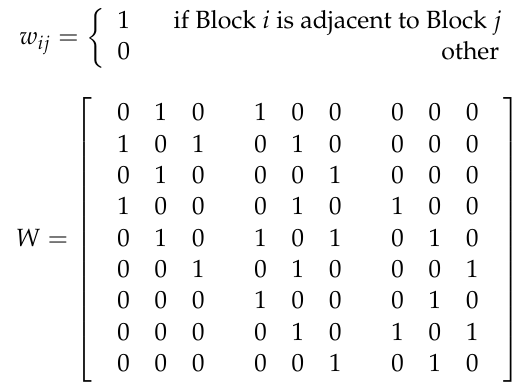
Figure 3. Spatial adjacency diagram.